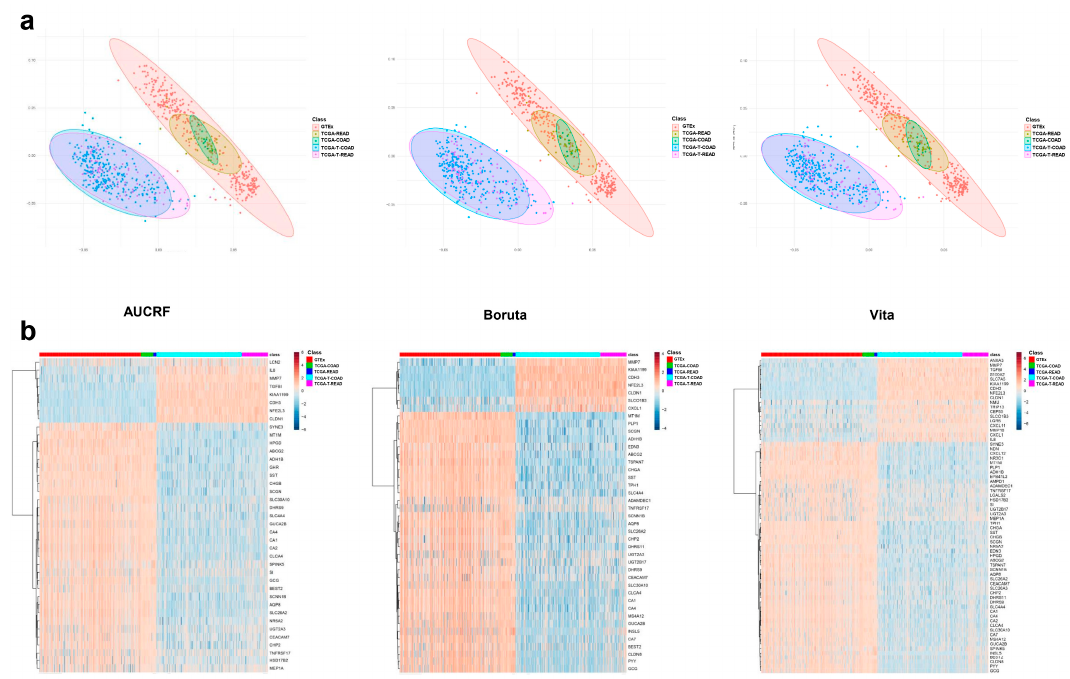
Figure 2. Data exploration of three sets of biomarker candidates. ( a ) Principal component analysis of three sets of biomarker candidates between cancer samples and non-cancerous samples. ( b ) Heatmap analysis of three sets of biomarker candidates between cancer samples and non-cancerous samples.